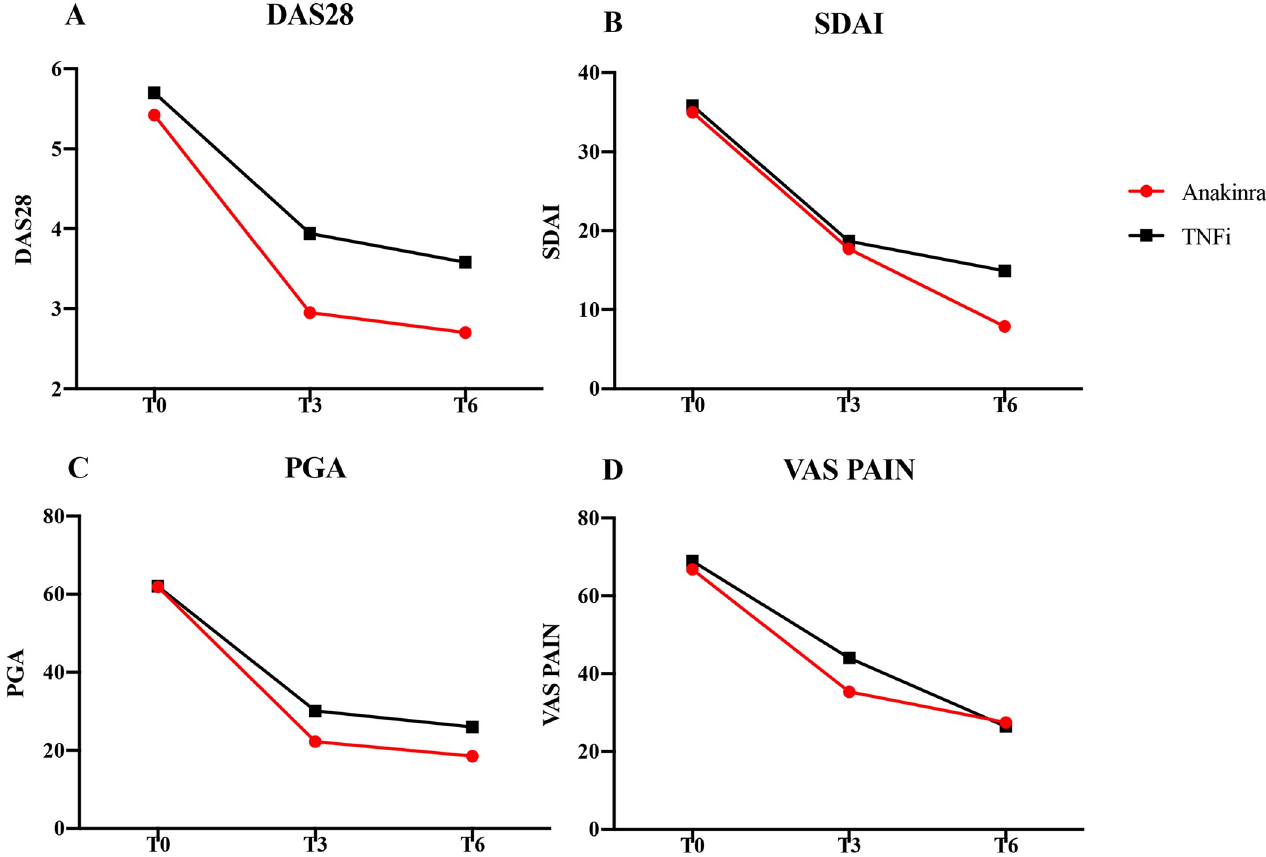
Fig 3. Measures of rheumatoid arthritis disease activity. Measures of rheumatoid arthritis disease activity at baseline (T0) and after 3 (T3) and 6 months (T6) of treatment with anakinra or TNFi. (A) DAS28. T0: anakinra group (5.42 ± 1.18) versus TNFi group (5.70 ± 0.80); T3: anakinra group (2.95 ± 1.58) versus TNFi group (3.94 ± 1.01), p = 0.039, T6: anakinra group (2.70 ± 1.16) versus TNFi group (3.58 ± 1.45), p = 0.08. (B) SDAI. T0: anakinra group (34.98 ± 25.18) versus TNFi group (35.86 ± 3.47); T3: anakinra group (17.70 ± 10.53) versus TNFi group (18.69 ± 29.55), p = 0. 90; T6: anakinra group (7.89 ± 9.23) versus TNFi group (14.93 ± 9.92), p = 0.0048. (C) PGA. T0: anakinra group (61.90 ± 19.17) versus TNFi group (62.00 ± 17.81); T3: anakinra group (22.21 ± 21.86) versus TNFi group (30.13 ± 19.66), p = 0.27; T6: anakinra group (18.53 ± 23.53) versus TNFi group (25.97 ± 19.99), p = 0.45. (D) VAS of pain. T0: anakinra group (66.86 ± 29.46) versus TNFi group (68.94 ± 22.86); T3: anakinra group (35.37 ± 23.74) versus TNFi group: (44.00 ± 21.98), p = 0.28; T6: anakinra group (27.47 ± 21.67) versus TNFi group (26.46 ± 28.38), p = 0.24. DAS28, Disease Activity Score-28; PGA, physician global assessment; SDAI, simplified disease activity index; TNFi, tumour necrosis factor inhibitor; VAS, visual analogue scale.